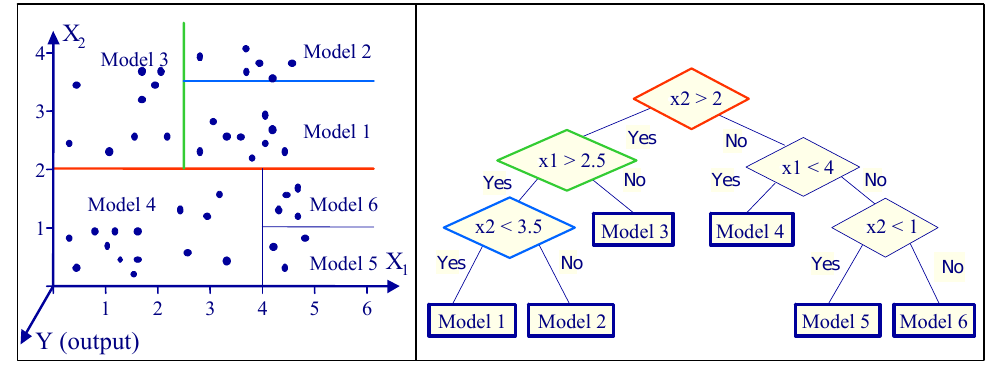
Figure 2. Illustration of splitting in a model tree Fig. 2. Illustration of splitting in a model